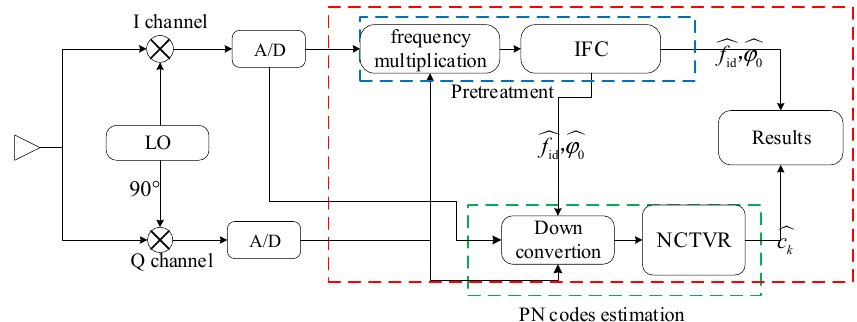
Figure 2. Diagram of the NCTVR-based method. LO: local